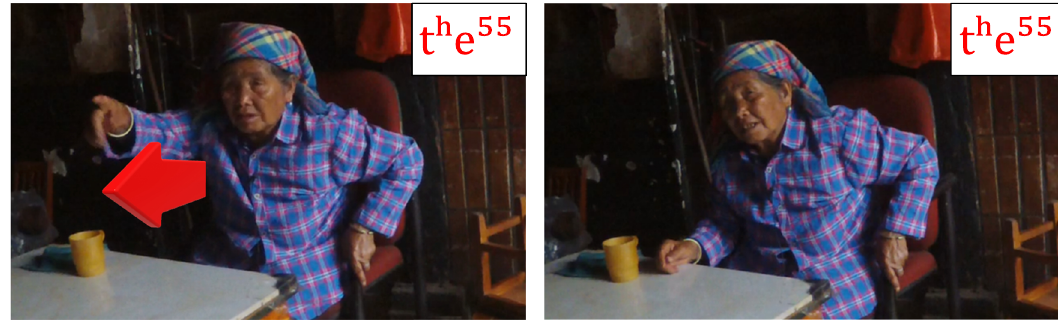
Figure 12: t ʰ e ⁵⁵ . Co - timed with pointing before, but not after, the addressee fi nds the